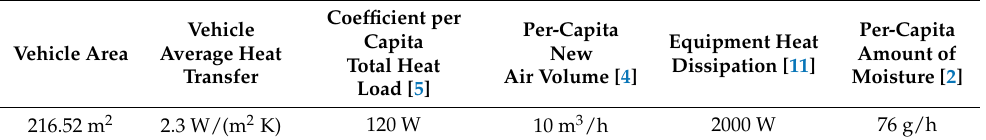
Table 3. Other relevant parameters required for the calculation of the air-supply volume of air- conditioning units.